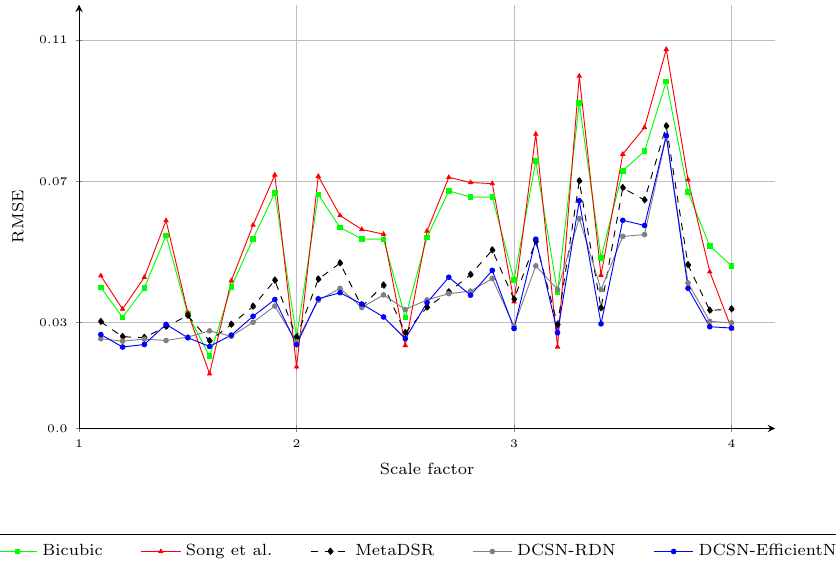
Figure 14. The RMSE of different methods for different upsampling factors [ 1.1,1.2,...,3.9,4.0 ] on the NYUv2 dataset after fine-tuning. We report the results of the modality in [40] trained with arbitrary scale factors, instead of the one that was trained with specific scale factors. Note that the results of the method of Song et al. for noninteger scale factors were obtained by applying bicubic interpolation on the upscaled results of the nearest integer scale